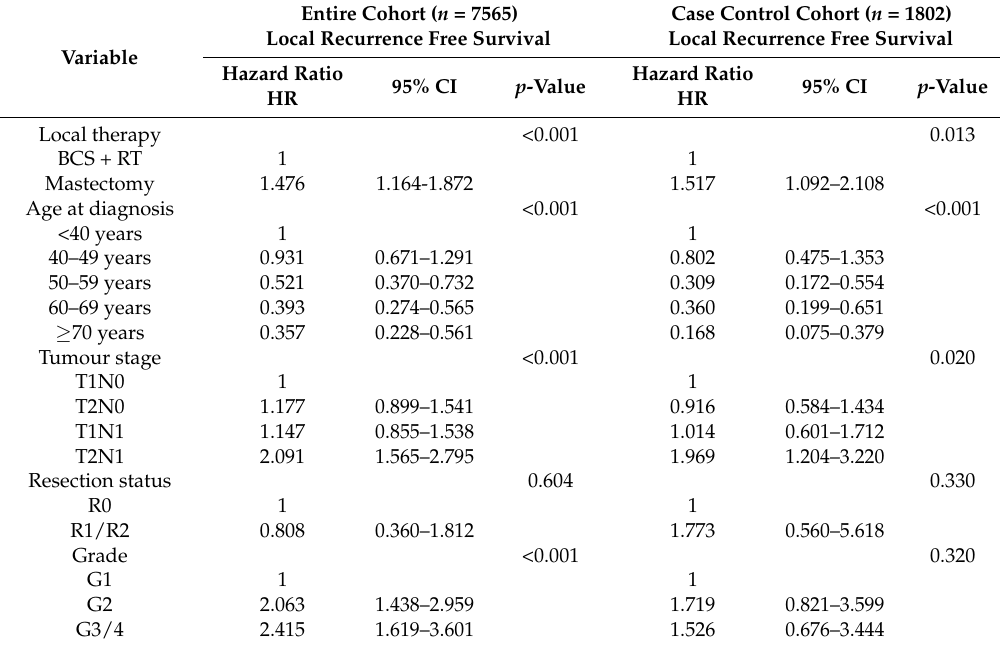
Table 3. Multivariable Cox regression analysis for local recurrence free survival.